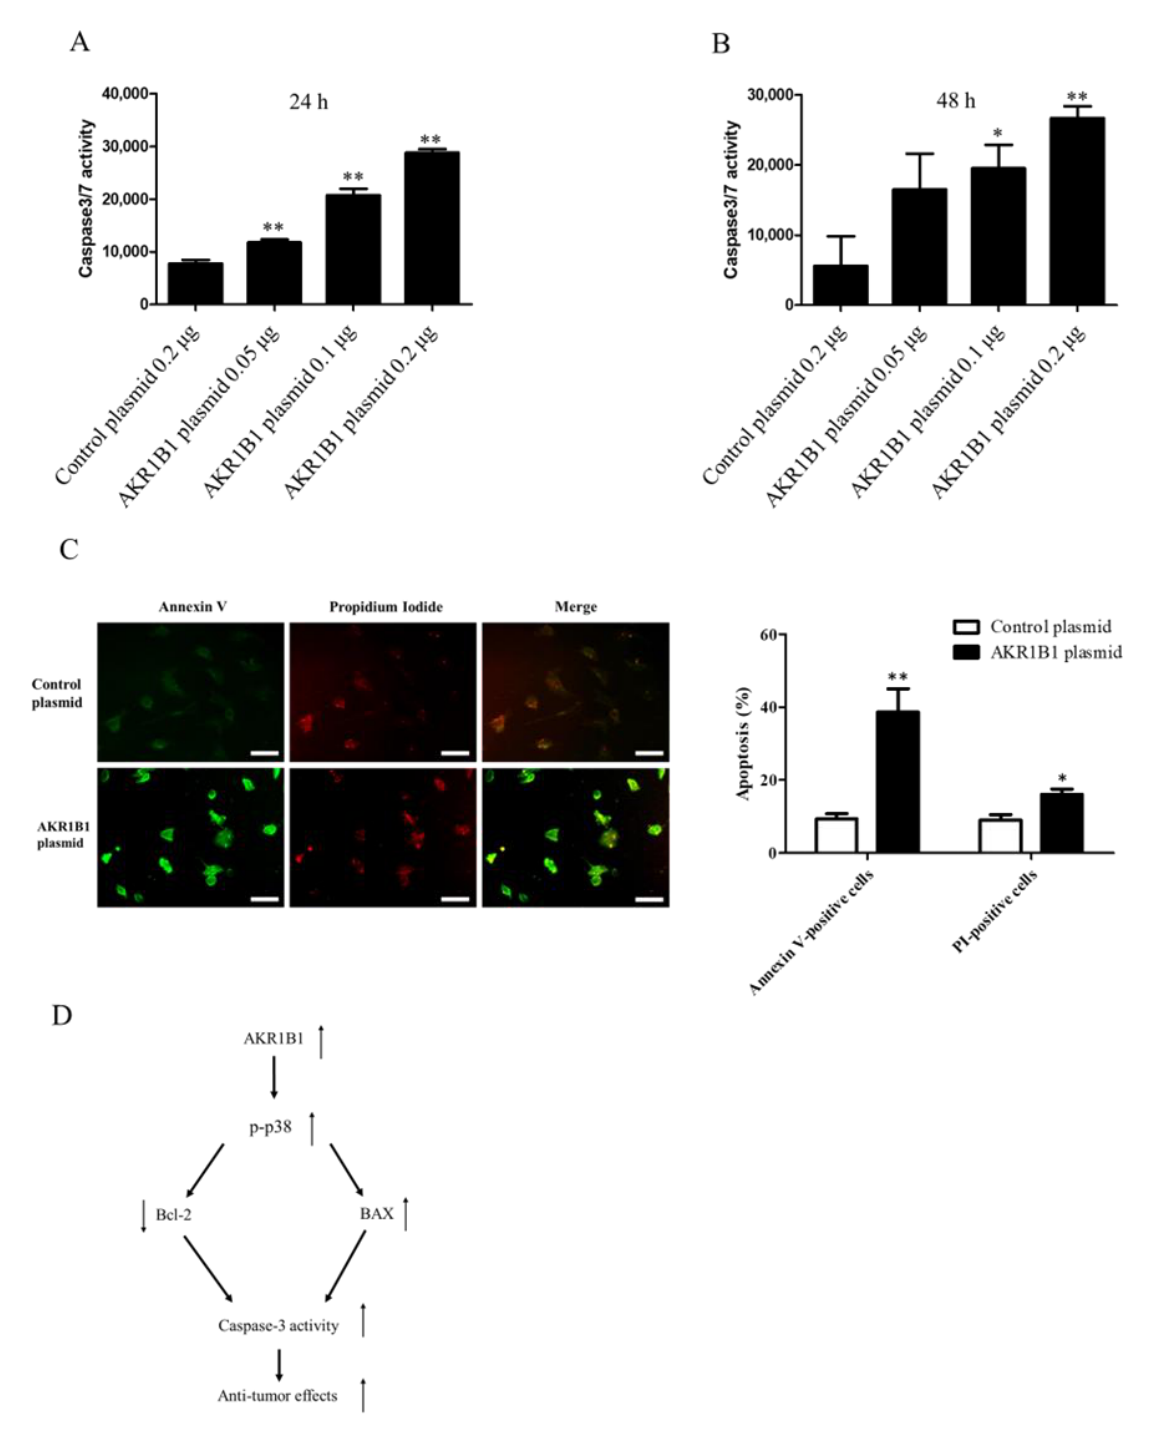
Figure 6. AKR1B1 induced cell apoptosis by activating caspase 3/7 activity in glioma cells. ( A , B ) AKR1B1 increased caspase3/7 activity in human glioma cells. T98 cells were transfected with the control plasmid or 0.05/0.1/0.2 μg of the AKR1B1-expressing plasmid. Then, the caspase 3/7 activity was measured at 24 h ( A ) and 48 h ( B ) after plasmid transfection. Data are presented as mean ± SEM from three independent experiments; * p < 0.05 and ** p < 0.01. ( C ) After treatment, cells were subjected to an Annexin-V/PI double staining assay. Specifically, the cells were stained with Annexin V-FITC (green) and PI (red) and subsequently analyzed using a fluorescence microscope. The scale bar represents 100 µ m. ( D ) A schematic diagram shows AKR1B1 exerting antitumor effects by activating the apoptotic